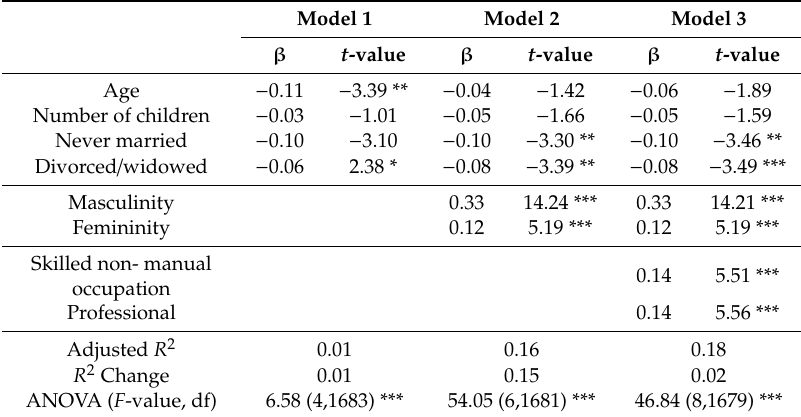
Table 5. Summary of the hierarchical regression with the psychological well-being factor as the dependent measure for the men’s